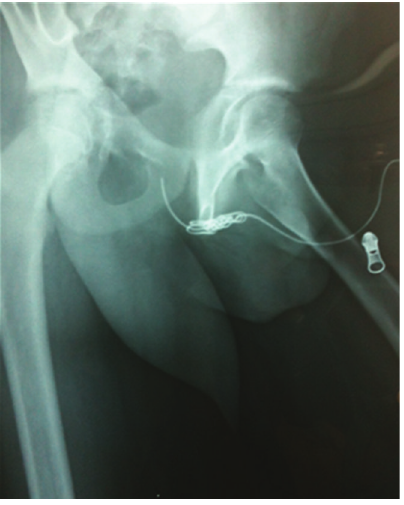
Figure 2: Pelvic plain radiography: twisted cable forming a coiled refractory structure in the posterior urethra.